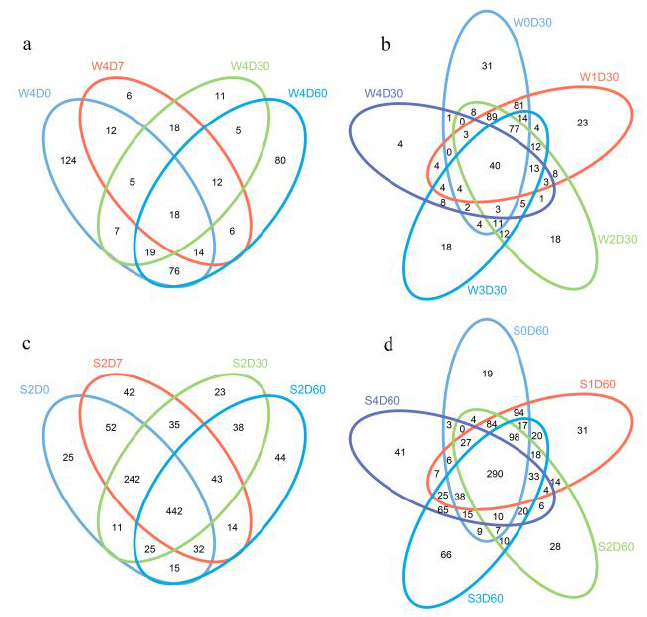
Figure 2. Effects of different concentrations of florfenicol on operational taxonomic units (OTUs) of bacteria (Venn diagram) in an aquatic microcosm model. ( a ) Effect of sampling time on OUTs of bacteria in group W4 samples. ( b ) Effects of different concentrations of florfenicol on OTUs of bacteria in water samples at 30 days. ( c ) Effect of sampling time on the OUTs of bacteria in group S2 samples. ( d ) Effects of different concentrations of florfenicol on OTUs of bacteria in sediment samples at 60 days. W, water; S, sediments. Differently colored circles represent different samples, and the numbers represent the number of unique OTUs in each sample or the number of common OTUs to all samples.